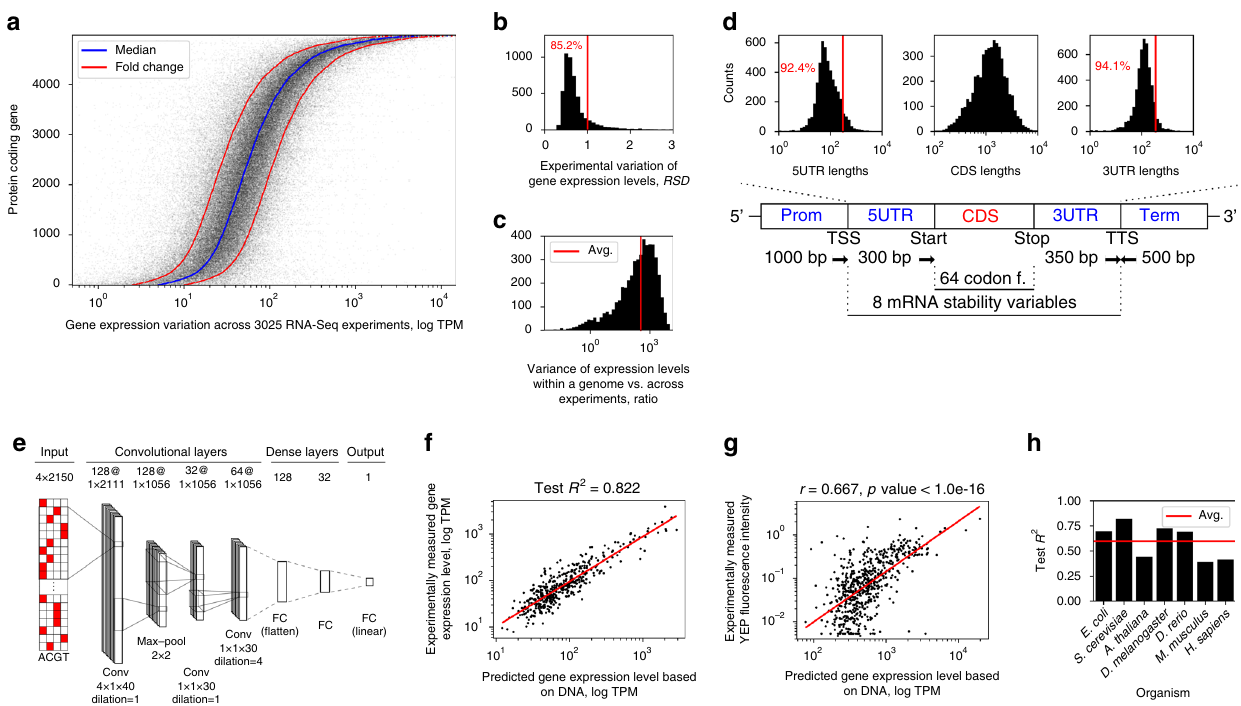
Fig. 1 The dynamic range of gene expression levels is encoded in the DNA sequence. All results shown are for S. cerevisiae , except in (h). a Expression levels (transcripts per million, TPM) of protein-coding genes across 3025 RNA-seq experiments. Inset: distribution of genes with a relative standard deviation ( RSD = σ / μ ) below 1. b Experimental variation of the gene expression levels expressed as RSD . c Distribution of ratios between the variance of expression levels within a genome and the variance of expression levels per gene across the experiments. d Schematic diagram of the explanatory variables used for modeling, with distributions of the sequence lengths in the regions where the lengths varied. “ TSS ” denotes the transcription start site and “ TTS ” the transcription termination site. e The optimized deep neural network (NN) architecture, where “ conv ” denotes convolutional NNs, “ FC ” fully connected layers, and “ max-pool ” max-pooling layers. The values denoting sizes of parameters layers , stride , kernels , fi lters , max-pooling , and dilation are speci fi ed. f Experimentally determined (true) versus predicted expression levels with the S. cerevisiae model on the held out test dataset ( n = 425). Red line denotes least squares fi t. g Comparison of published experimental fl uorescence measurements 44 with the predicted expression levels ( n = 625). Red line denotes least squares fi t. h R 2 on held out test datasets across 7 model organisms. Red line denotes mean value. Source data are provided as a Source data fi levels inferred based on the DNA sequences of the synthetic (Pearson ’ s r from 0.570 up to 0.718, p -value < 1e-16) with the